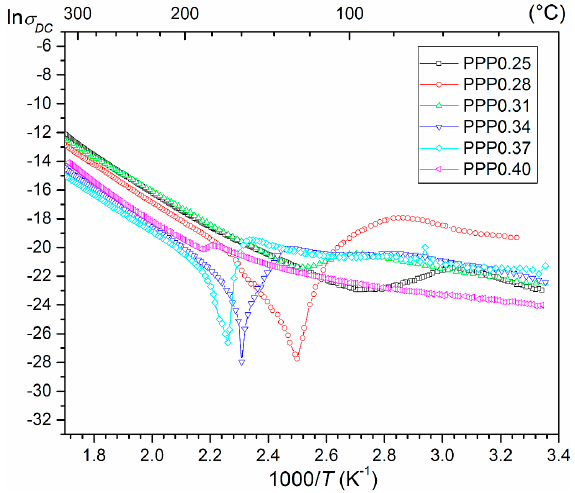
Figure 4. The ln σ DC (1/ T ) relationship for the PMN–PT–PS solid solutions.